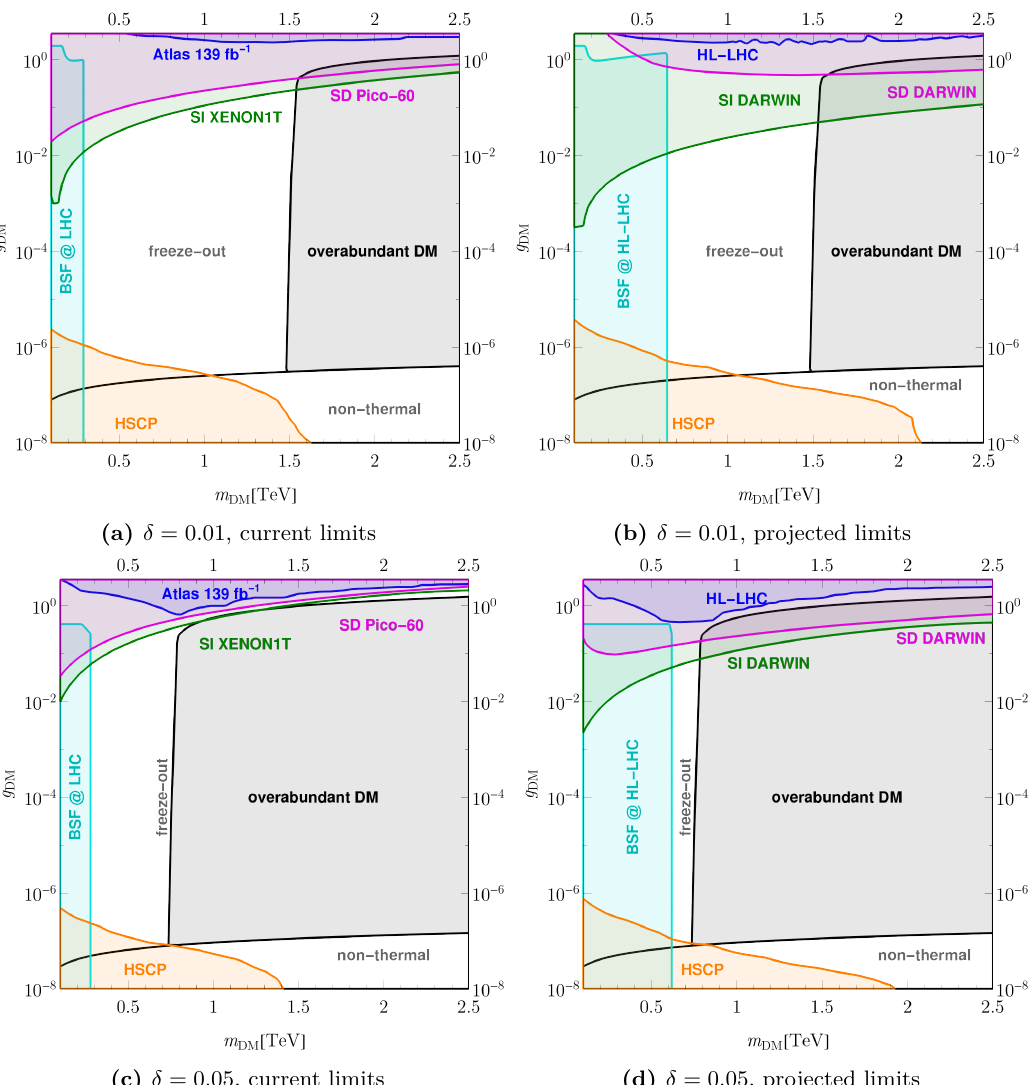
Figure 13. Future and current limits are shown in the ( m DM , g DM ) -plane for a fixed relative mass splitting δ . The limits from spin-independent direct detection (spin-dependent direct detection, prompt collider searches, long-lived particle searches, bound state searches at colliders) are shown in green (magenta, blue, orange, cyan). Additionally the plane is split into three regions. Firstly a region for small couplings where DM production proceeds non-thermally, secondly a freeze-out region where DM is either underproduced or matches the observed relic density, which coincides with the boundary of this region to the area of parameter space where DM is overabundant.